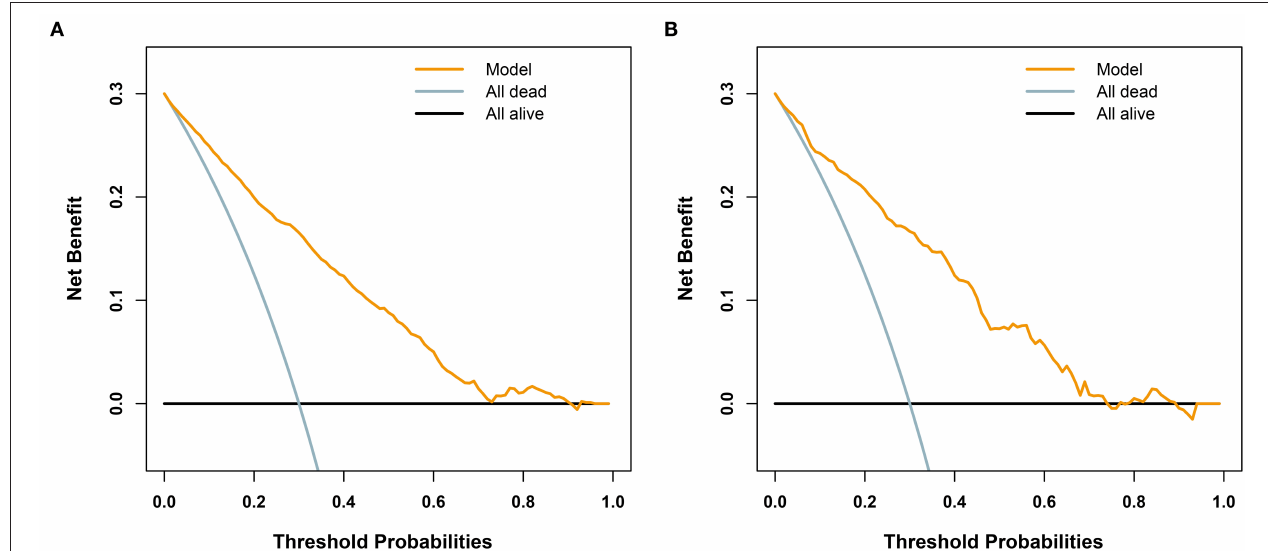
FIGURE 5 | Decision analysis curves for the developed model for predicting 72-h mortality in patients with polytrauma. The black line represents a scheme to make all patients alive. The light blue line represents an improper protocol, leading to all patient mortality that occurred during the course of the study. The yellow line represents net benefits of the clinical application of the model. (A) In the training cohort ( n = 2461), when the threshold is between 0.01 and 0.9, the model is applicable, since the net benefit is > 0. (B) In the validation cohort (n = 614), the valid range is between 0.01 and 0.74.